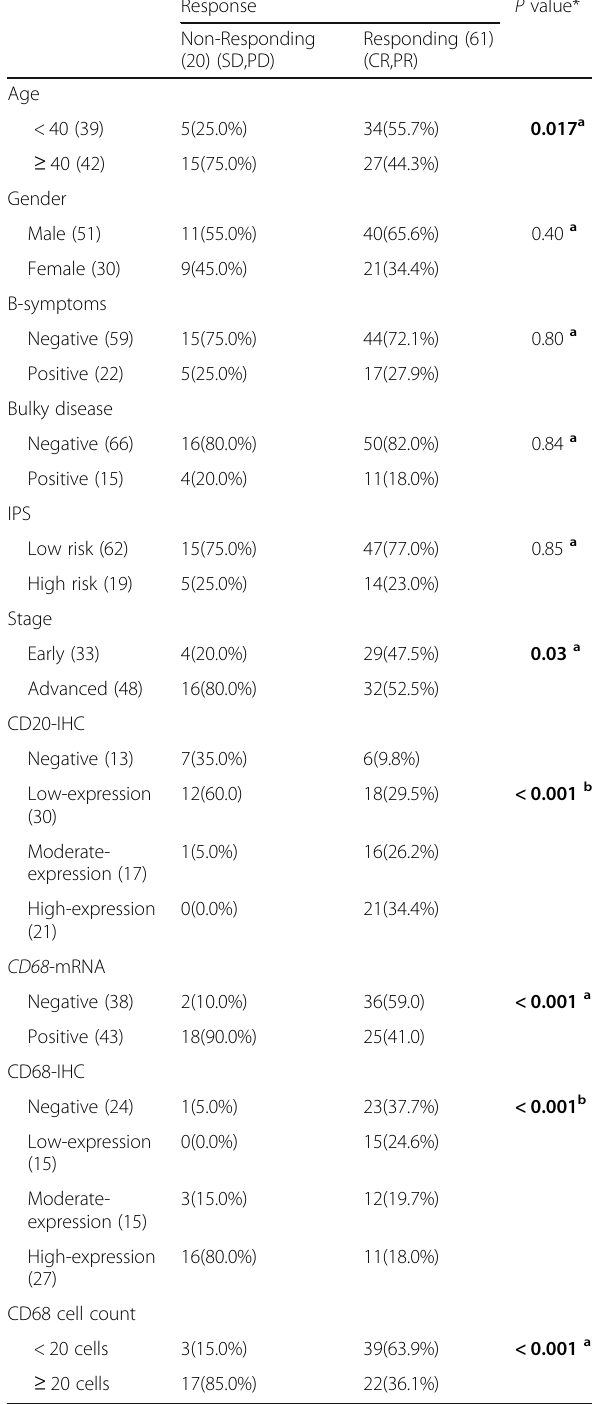
Table 4 Patients ’ response to treatment